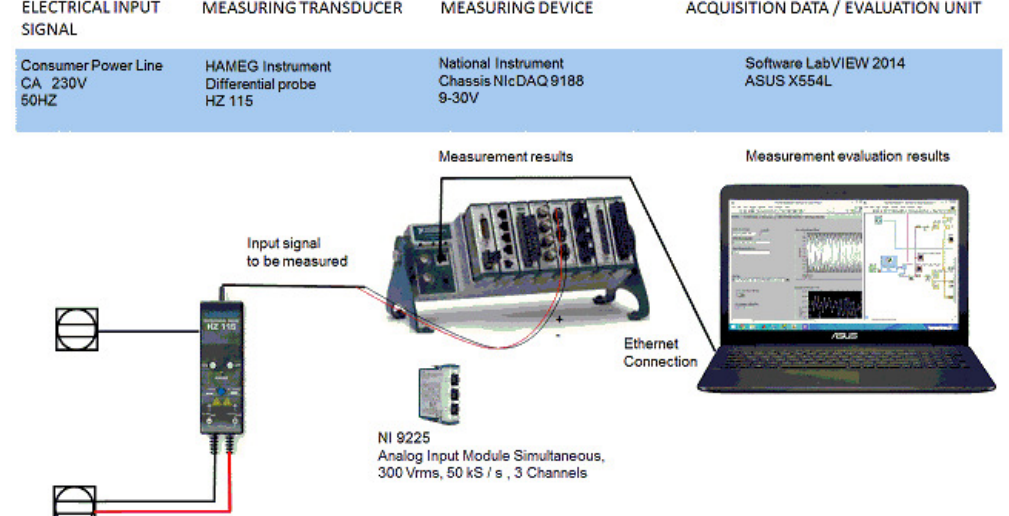
Figure 1. Experimental arrangement. A differential probe is connected to the power supply. The data are processed through labVIEW TM .